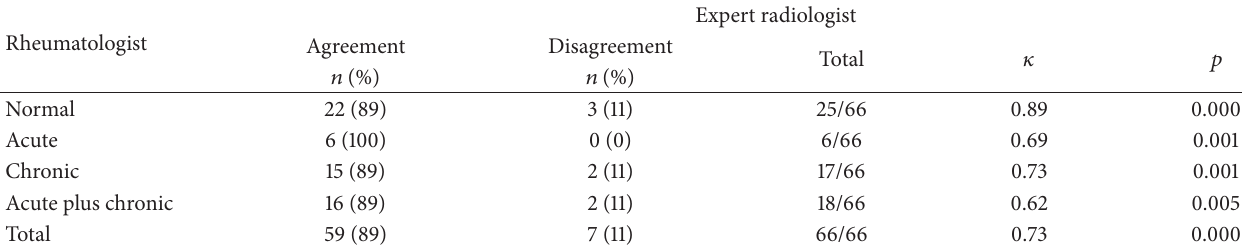
Table 3: Interobserver agreement between expert radiologist and